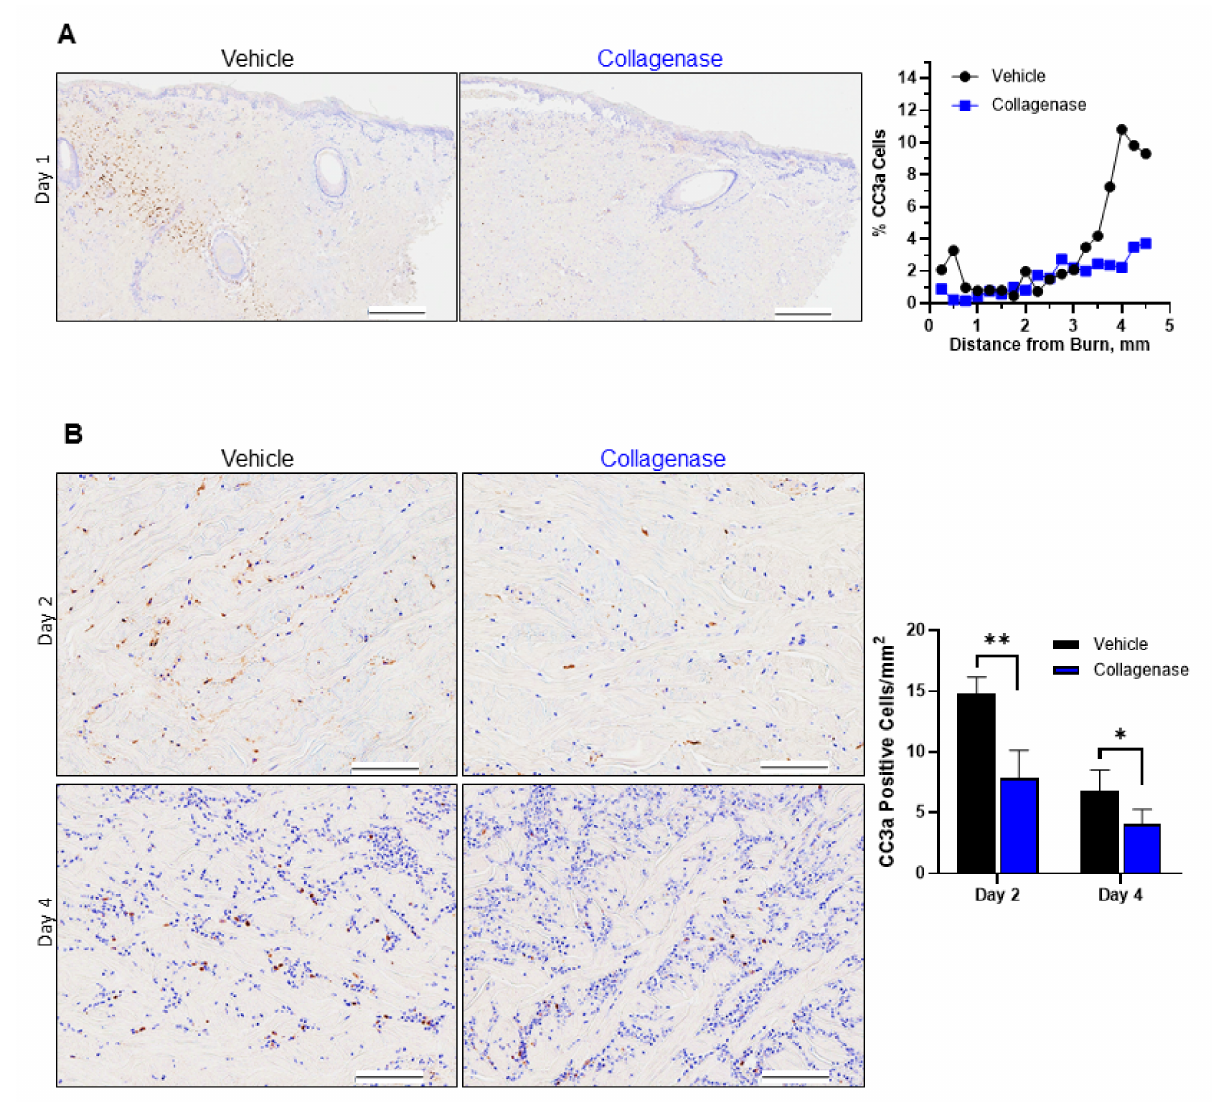
Figure 5. Collagenase-treated burns show limited apoptosis. Cleaved caspase 3a (CC3a) staining pattern in porcine burn interspaces on various days in wounds treated with vehicle and collagenase hydrogels. ( A ) Tissue biopsies from day 1 showed collagenase prevented burn-induced apoptosis in the burn wound surrounding area, while there was a significant increase in apoptosis observed in the wound interspaces for vehicle-treated burns. Percent (%) CC3a cells was calculated from the total number of positive stained CC3a cells/total cells as shown by hematoxylin blue stain × 100%. Black scale bars represent 500 µ m. ( B ) CC3a staining pattern of wound interspace sections on days 2 and 4 for vehicle and collagenase treatments. Collagenase treatment showed CC3a staining pattern with significantly less CC3a stain, indicative of limitation of burn-induced apoptosis, relative to treatment with vehicle that showed greater CC3a staining, indicating increase in apoptosis in the burn interspaces of vehicle-treated wounds. Black scale bars represent 100 µ m. Number of CC3a-positive cells/mm 2 was calculated from the total number of CC3a-positive cells/total area in mm 2 as visualized by CC3a stain. Values represent mean of 4 biopsies per time point and per treatment ( n = 4) ± SD. * p < 0.05; ** p <